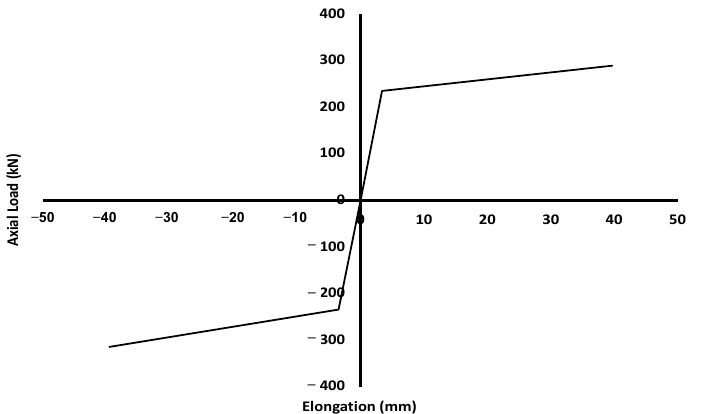
Figure 5. Load deformation relationship adopted for modeling BRB2 based on previous test results [39].